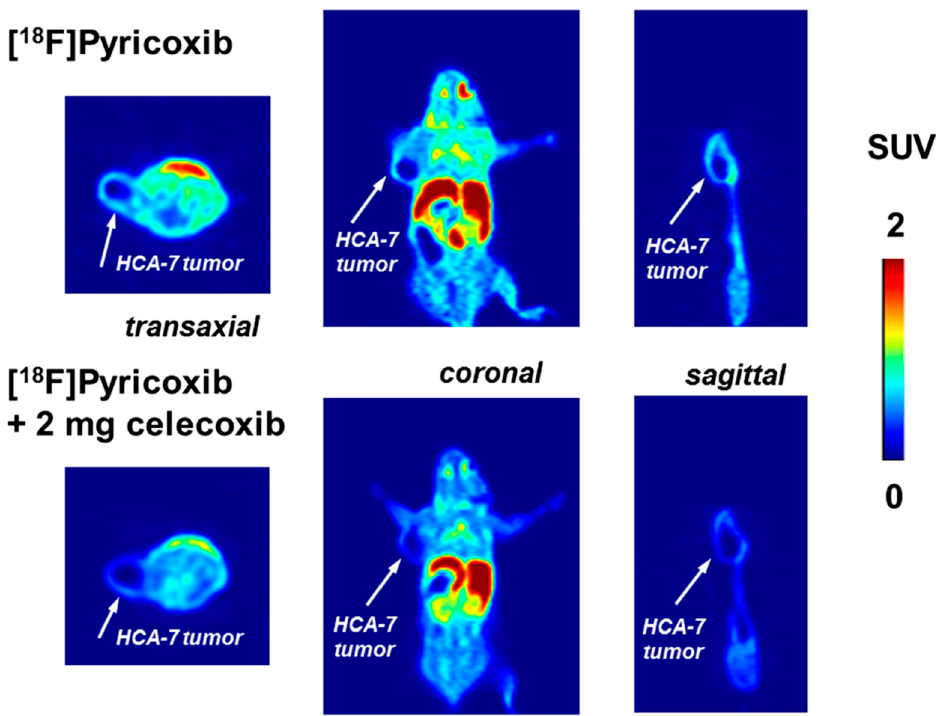
Figure 8. Top: transaxial, coronal, and sagittal PET images at 60 min p.i. of [ 18 F]Pyricoxib into HCA-7-tumor-bearing NIH-III mouse (control); bottom: transaxial, coronal, and sagittal PET images at 60 min p.i. of [ 18 F]Pyricoxib into HCA-7-tumor-bearing NIH-III mouse (pre-treated with 2 mg of celecoxib 60 min before radiotracer administration; no HSA added). Figure readapted with permission from publisher [76].